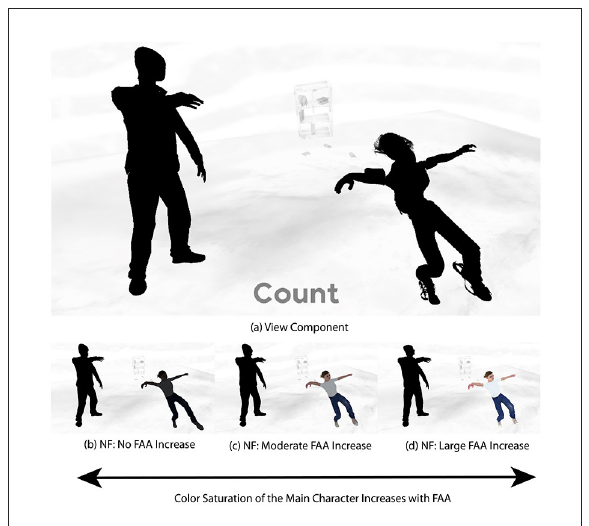
FIGURE7 Examples of varying FAA mapped to main character color. (a) View component, (b) NF: No FAA increase, (c) NF: Moderate FAA increase, (d) NF: Large FAA